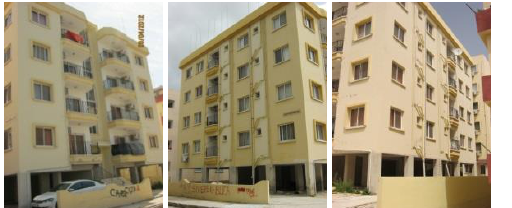
Muçize apartment (research’s field study, taken by author, 2016).